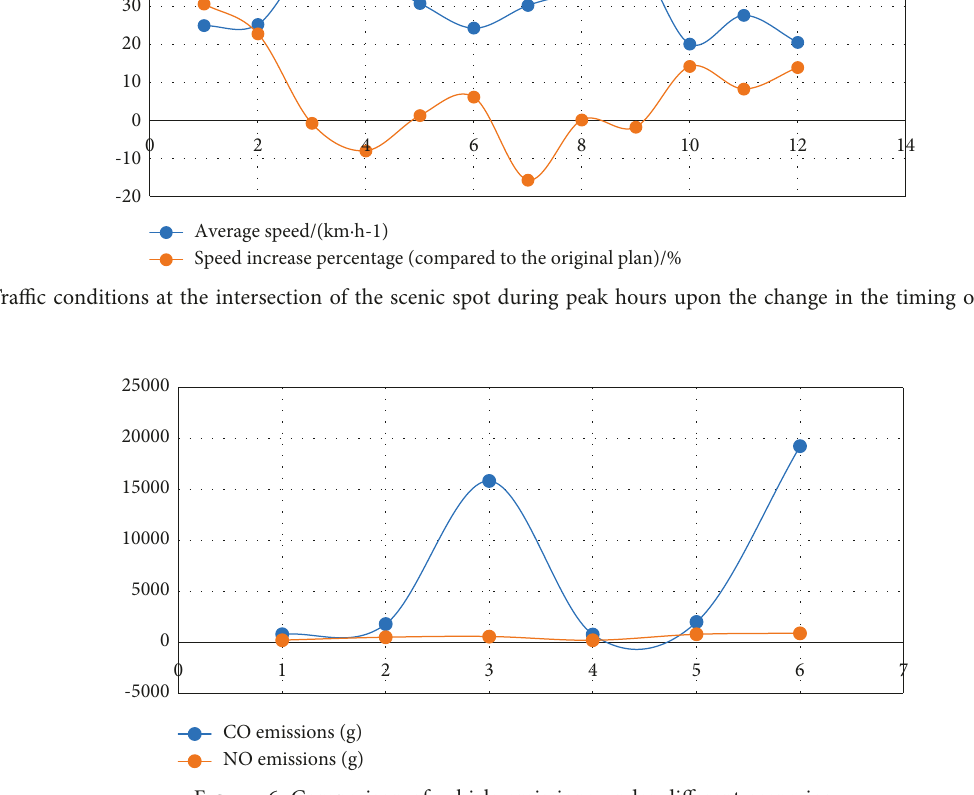
Figure 6: Comparison of vehicle emissions under different